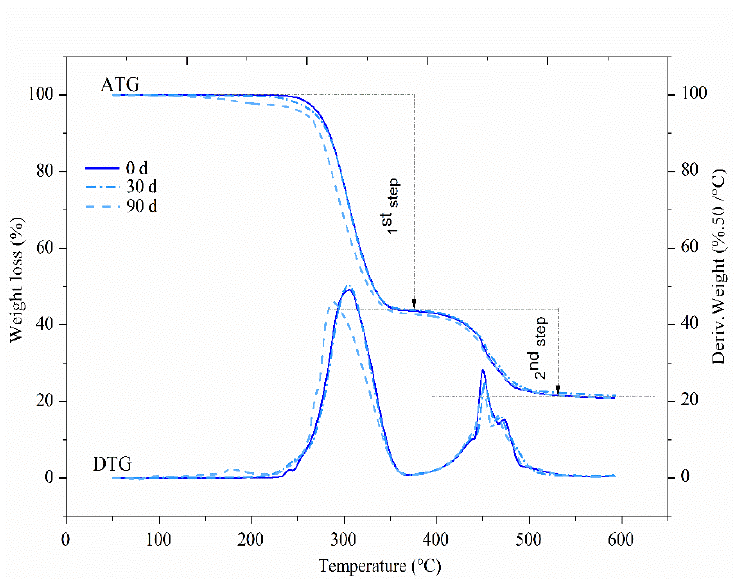
Fig. 7. Thermogravimetric and differential thermogravimetric (TG, DTG) curves of (u-PVC) aged at 100 °C for three aging stages (0, 30 and 90